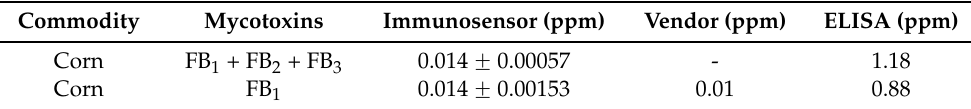
Table 3. Fumonisin content of certified corn reference